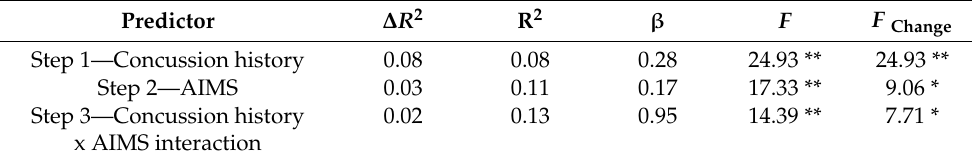
Table 2. Hierarchical regression analysis predicting concussion retirement